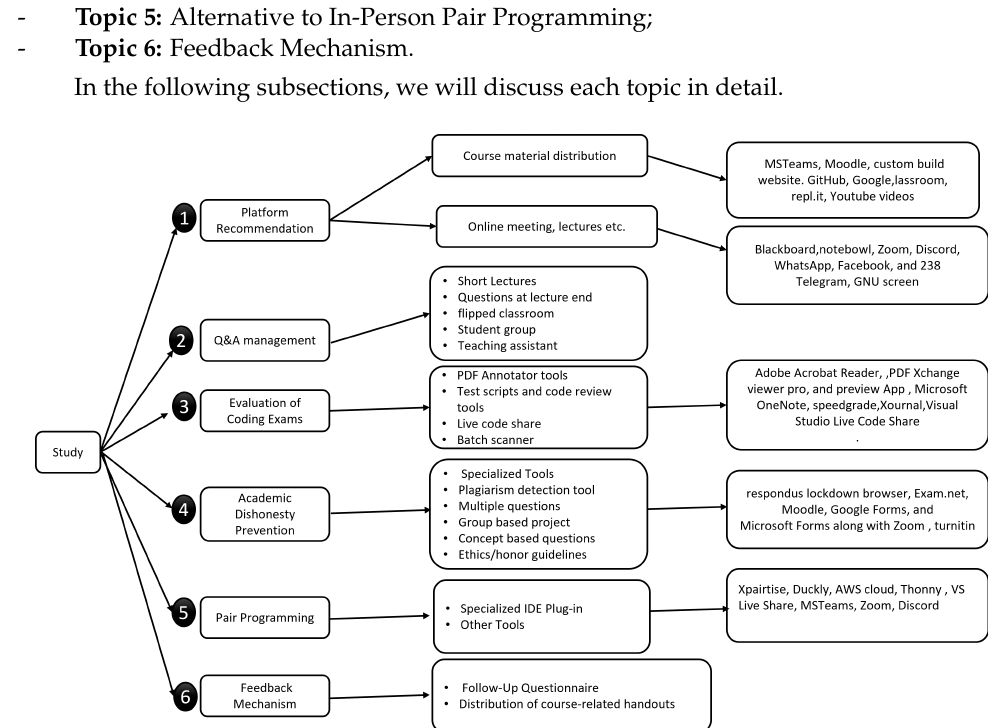
Figure 2. Overview of the various categories analyzed in this